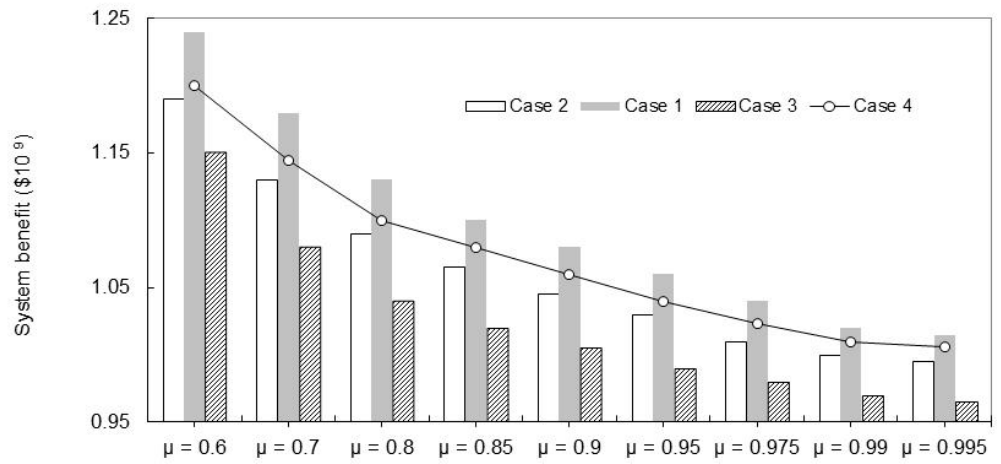
Figure 7. System benefits under various cases when µ levels are varied.